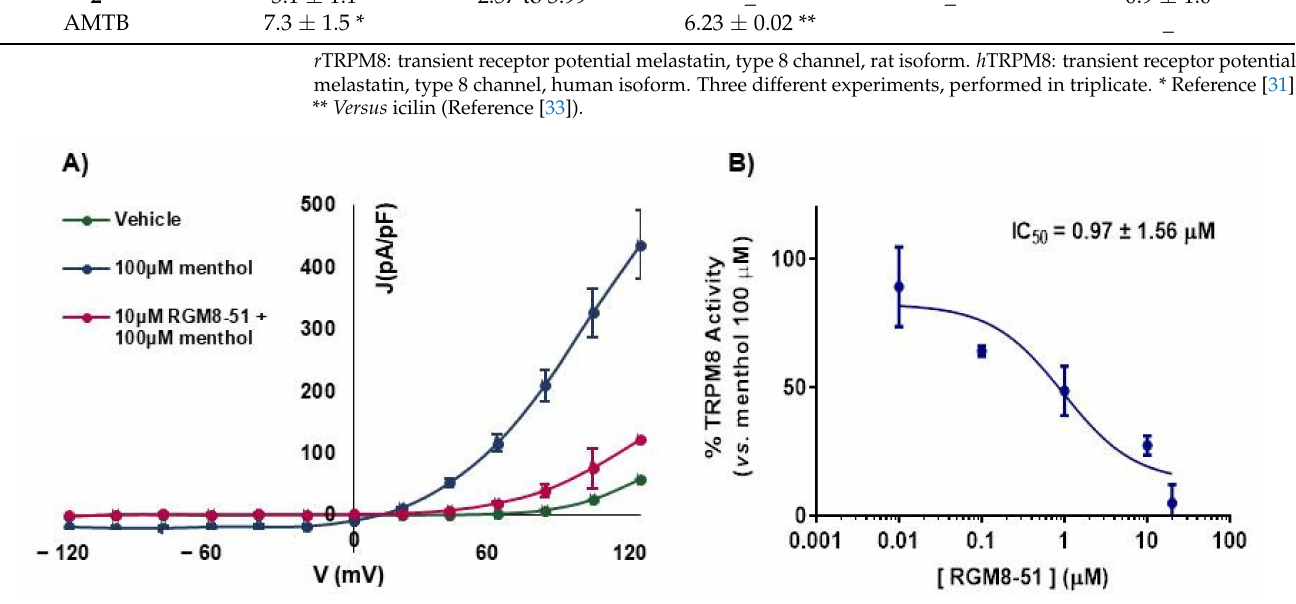
Figure 2. Compound 3 (RGM8-51) blocks TRPM8-mediated responses evoked by menthol in r TRPM8- expressing HEK293 cells. ( A ) IV curves obtained after exposure to vehicle solution (green